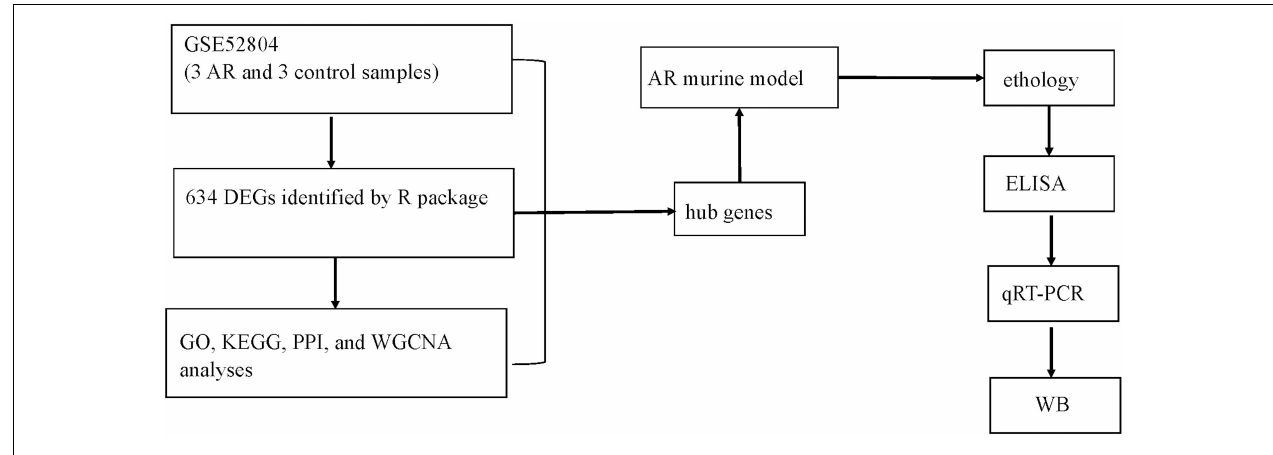
FIGURE 1 | Workflow diagram of data collection and analysis.